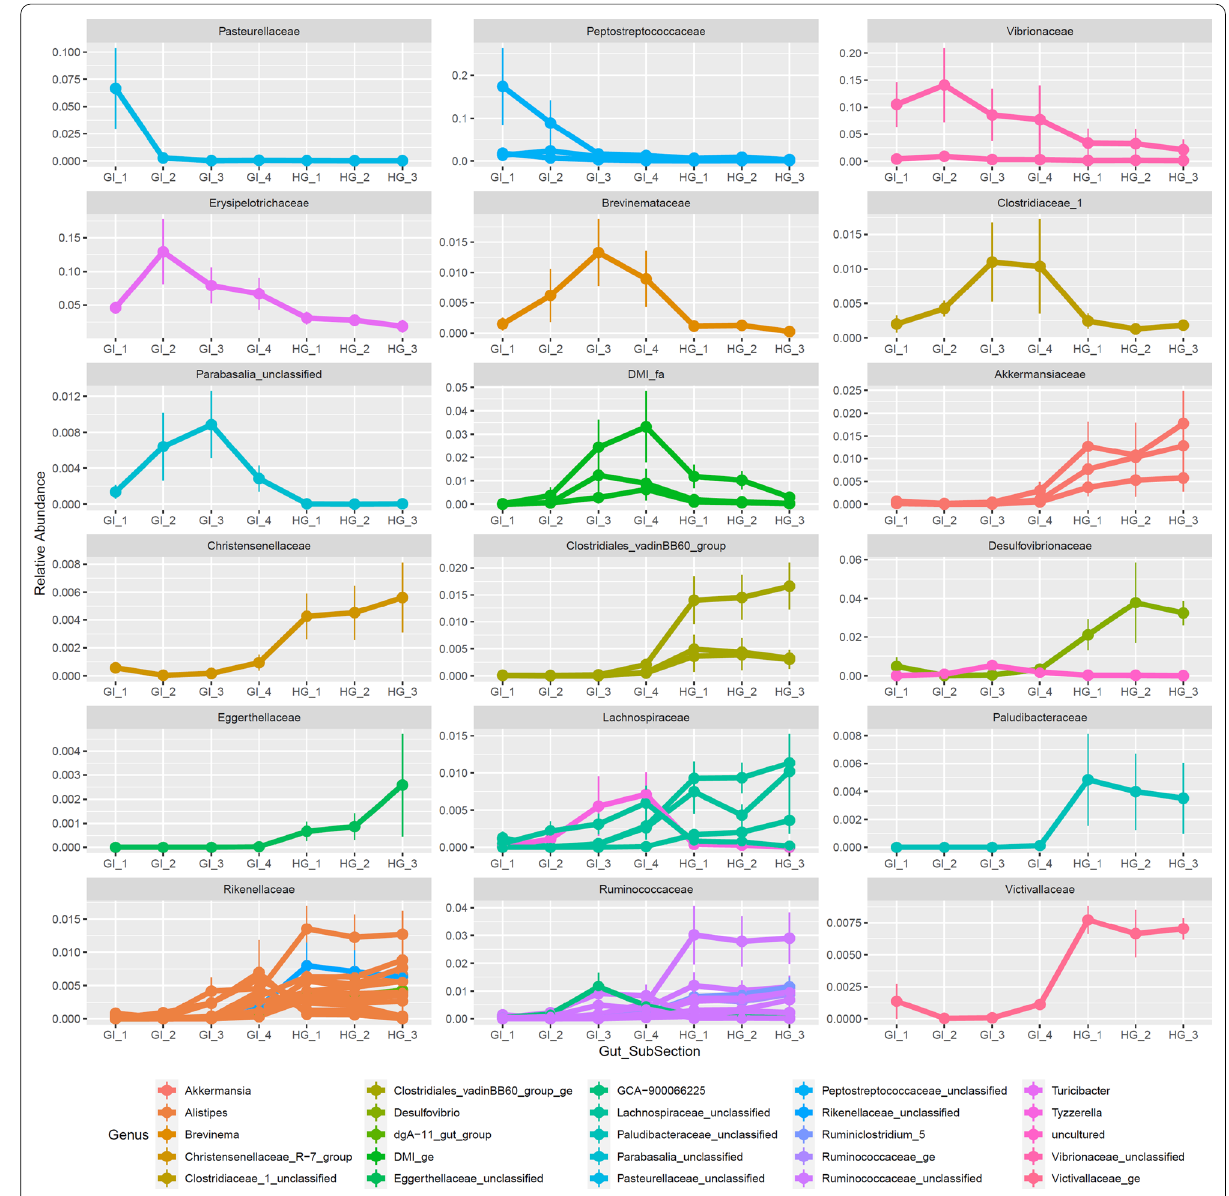
Fig. 5 Family-level trends across the Nenue gut in the 58 most abundant ASVs that responded significantly to gut subsection (adjusted p-value .05). Average ASV relative abundance is plotted against gut subsection, with plots separated by Bacterial Family, ASVs colored by Genus, ≥ and vertical lines indicating standard error. Plots are ordered by gut subsection enrichment from anterior to